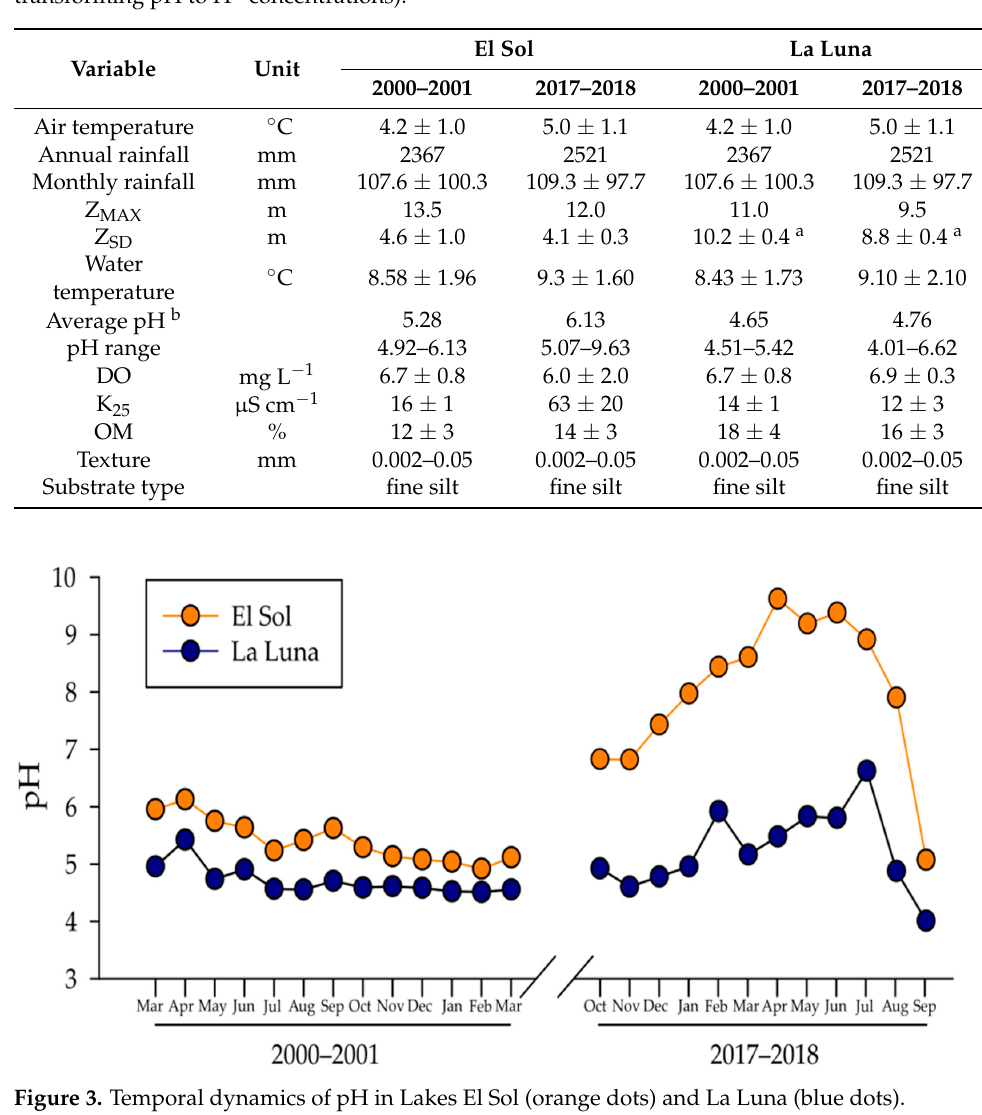
Table 1. Environmental variables (average ± standard deviation) of Lakes El Sol and La Luna, Nevado de Toluca, measured in 2000–2001 and 2017–2018 annual cycles. (Z MAX = maximum depth, Z SD = Secchi disk depth, a = total water transparency, DO = dissolved oxygen, K 25 = electrical conductivity, OM = sedimentary organic matter, Texture = average grain size). ( b = calculated by first transforming pH to H + concentrations).